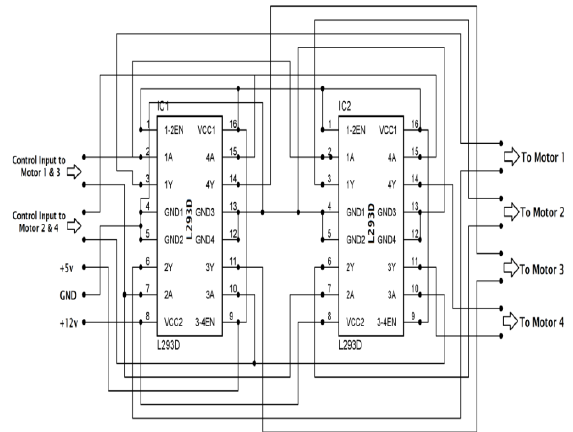
Figure 10. Circuit diagram of L23D Motor Driver